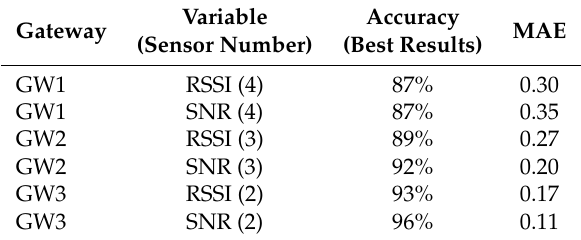
Table 5. Table of best results using the Hidden Markov Model (HMM) model obtained for each gateway.